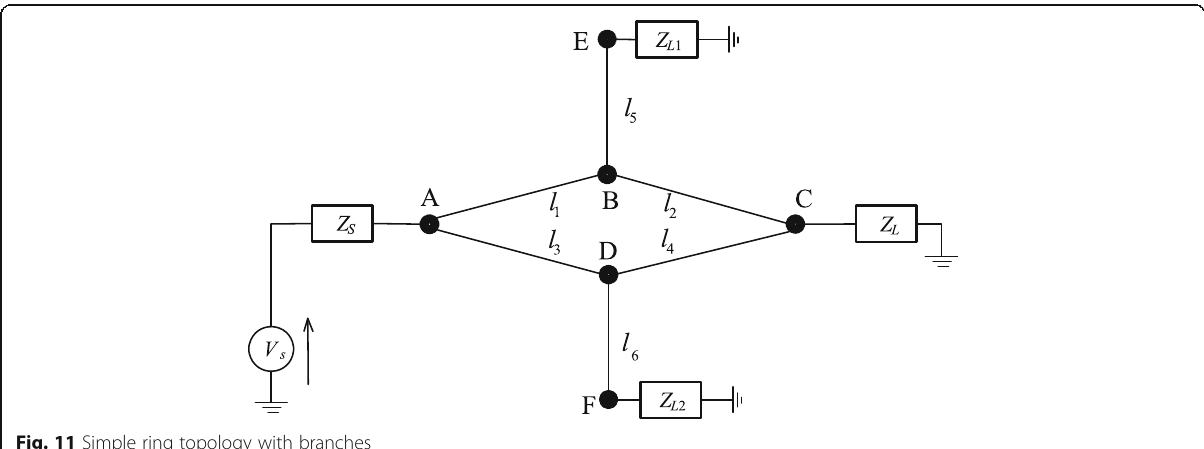
Fig. 11 Simple ring topology with branches